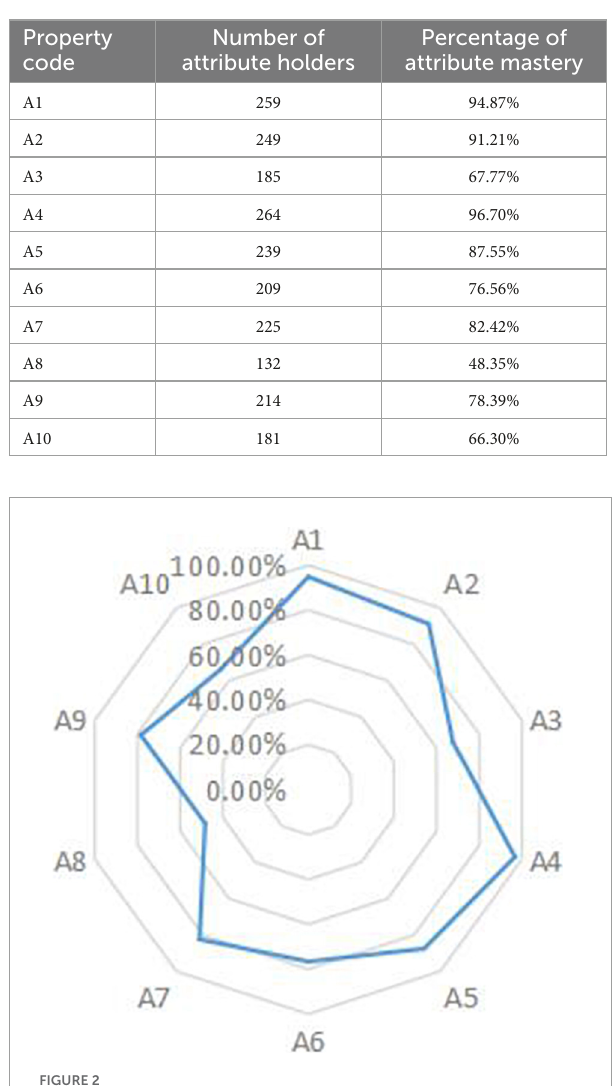
FIGURE2 Radar chart of student knowledge attribute